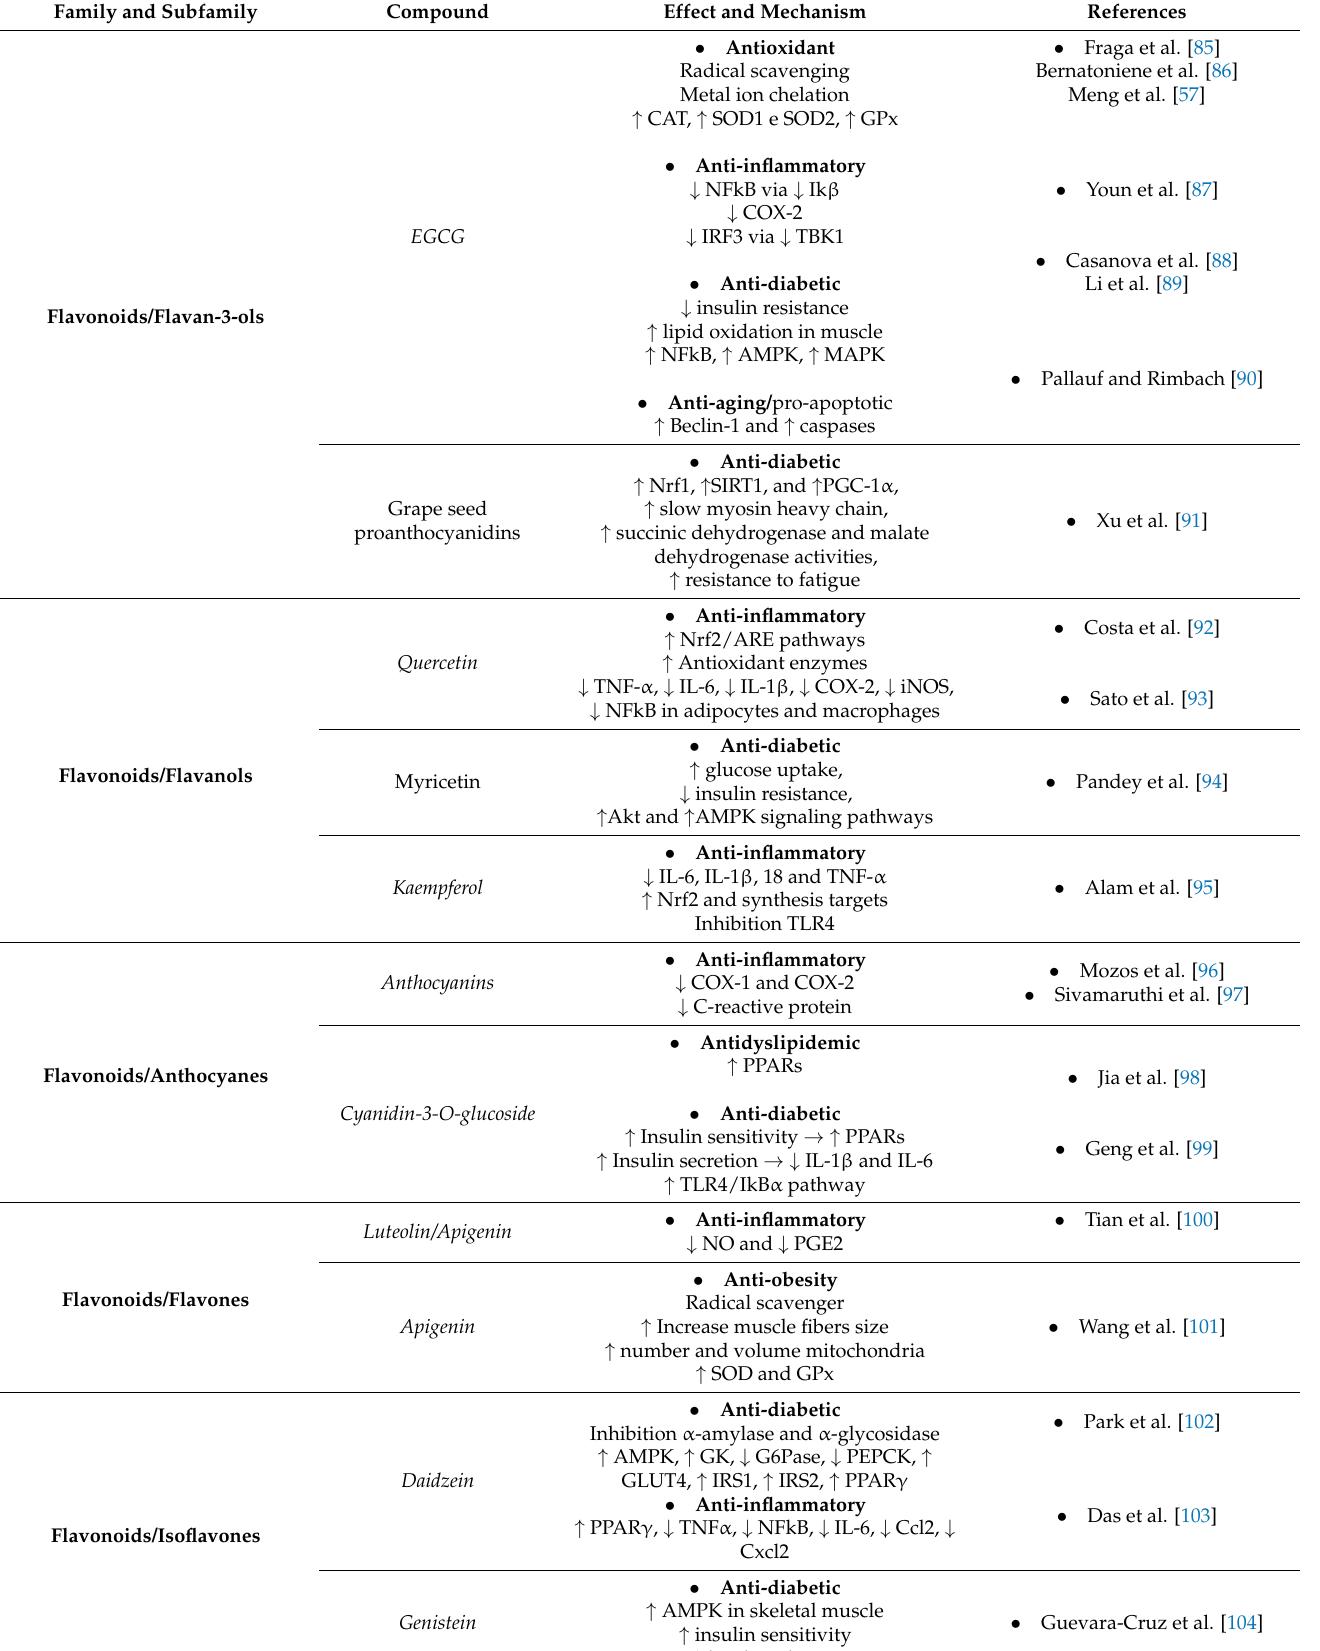
Table 2. Main effects of polyphenols present in grapes on mechanisms involved in obesity and